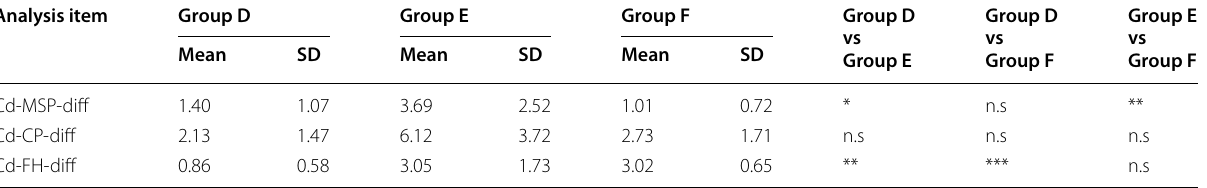
Table 2 Intergroup comparisons of analysis items based on condylar position relative to the skull base Analysis